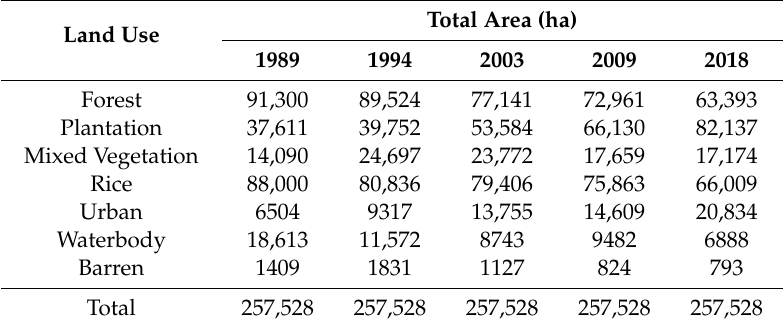
Table 4. The total area of land use in 1989, 1994, 2003, 2009, and 2018.